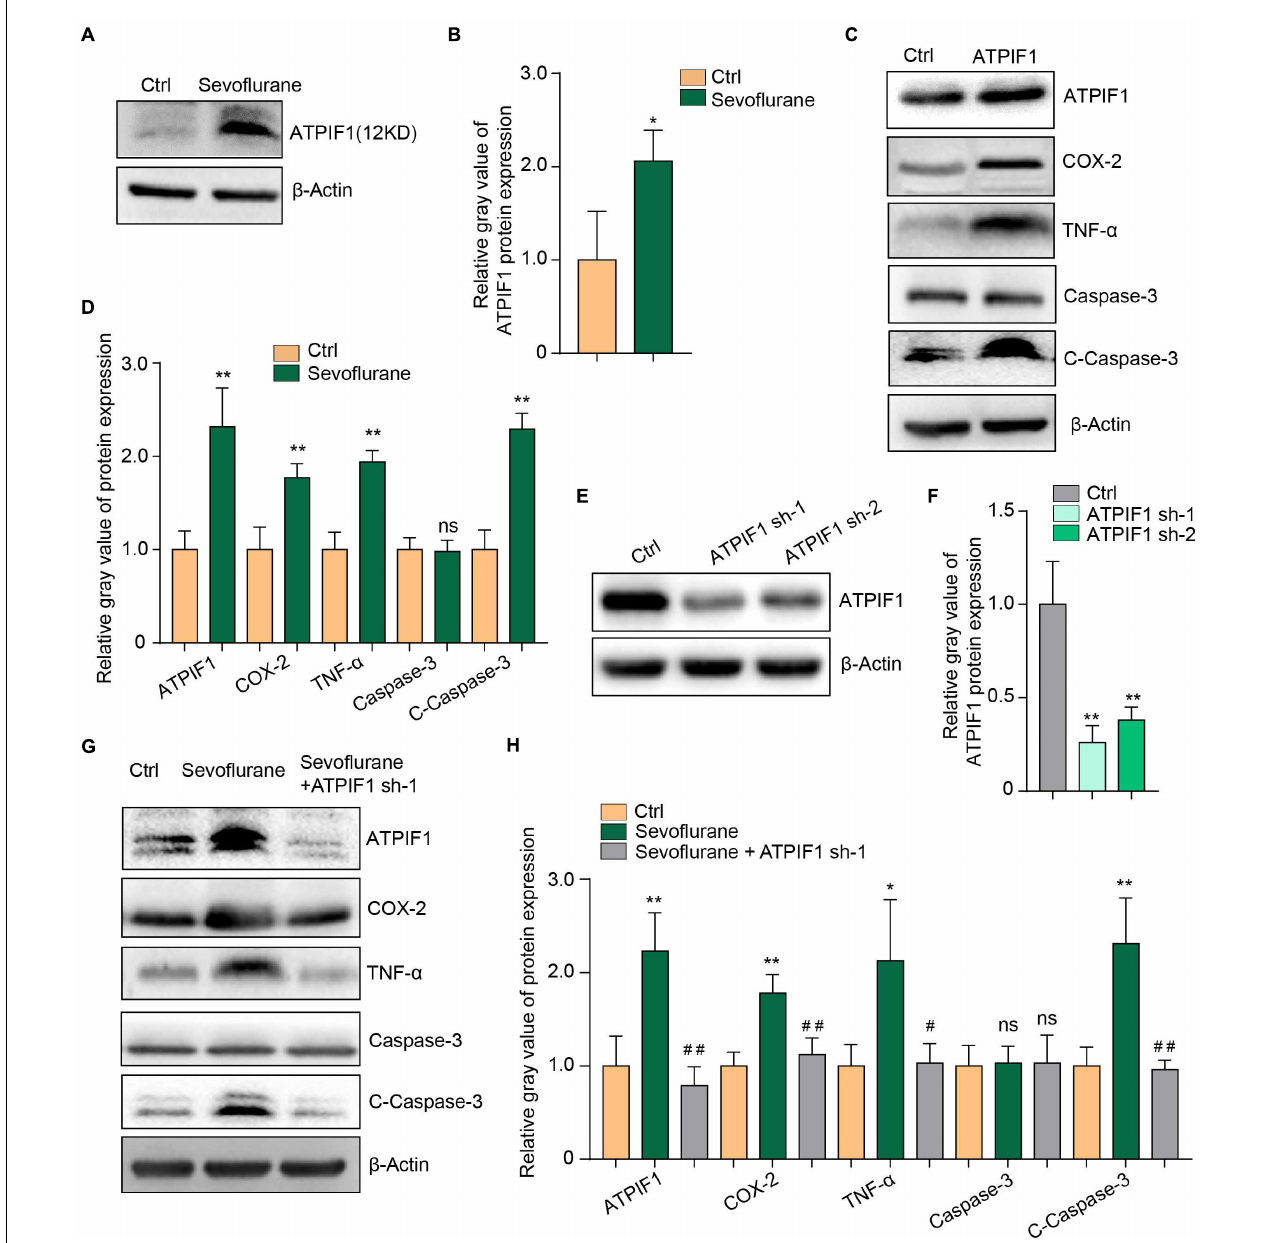
FIGURE 2 | ATPIF1 mediates sevoflurane-induced inflammation and caspase-3 activation in microglia. (A) Representative western blot image indicating that ATPIF1 expression was upregulated by sevoflurane treatment in mouse primary microglia. (B) Statistics of the relative gray value indicating the ATPIF1 protein expression in panel (A) . (C) Overexpression of ATPIF1 induced inflammation and caspase-3 activation in BV2 cells. (D) Statistics of the relative gray value indicating the protein expression in panel (C) . (E) Downregulation of ATPIF1 expression by shRNA in BV2 cells. (F) Statistics of the relative gray value indicating the ATPIF1 protein expression in panel (E) . (G) Downregulation of ATPIF1 attenuated the ATPIF1 upregulation caused by treatment with sevoflurane and attenuated the expression of the inflammatory factors COX-2 and TNF- α and the activation of caspase-3 to levels similar to those in the control group. (H) Statistics of the relative gray value indicating the ATPIF1 protein expression in panel (G) . β -Actin served as a loading control. Ctrl means control. Three independent repeated experiments were performed. Student’s t -test was used to determine differences in panels (B,D) . One-way ANOVA with repeated measurement were used to determine differences in panels (F,H) . The data shown are the means ± SD, n = 3. * or # means p < 0.05, ** or ## means p < 0.01. ns means no significant difference.